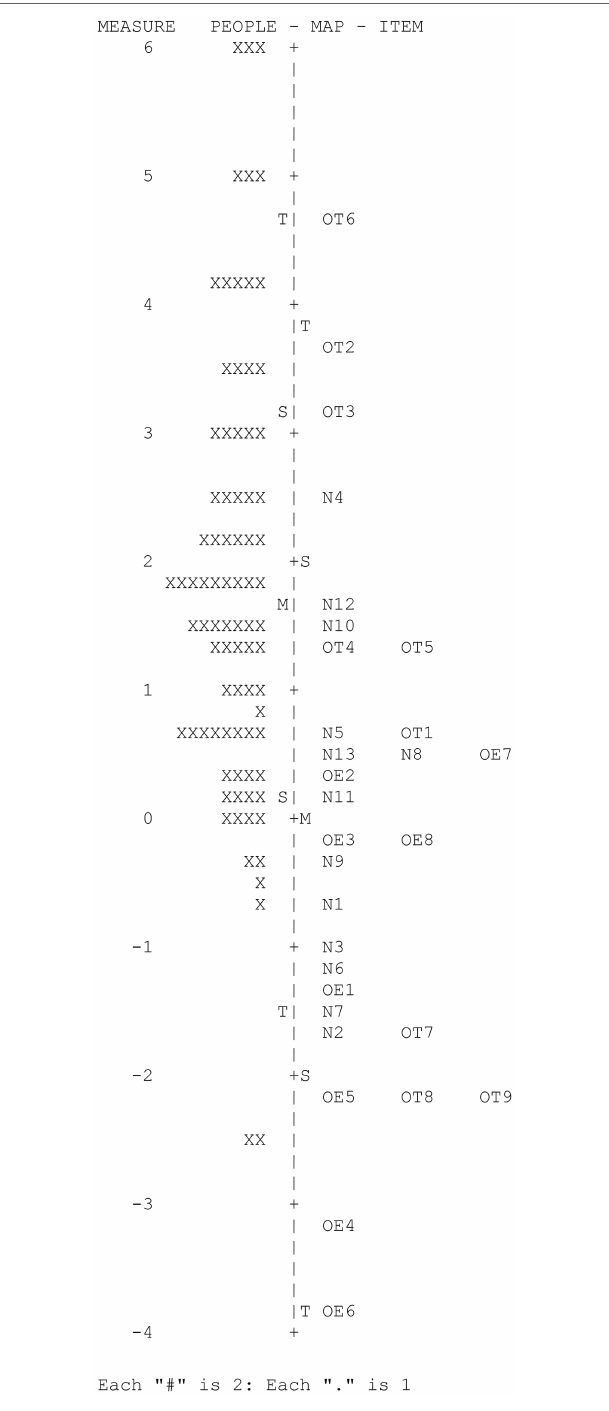
FIGURE 4 | CAPALIST-contextual information. Variable